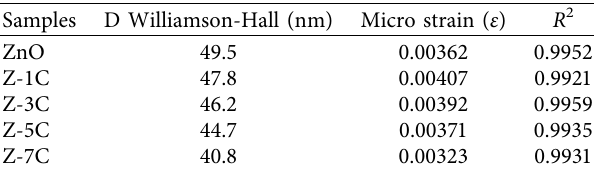
Figure 1: XRD pattern of g-C 3 N 4 @ZnO nanocomposite samples on the range from 20 to 80 o Table 1: The average crystallite size of ZnO and nanocomposite samples calculated via Williamson-Hall formula.